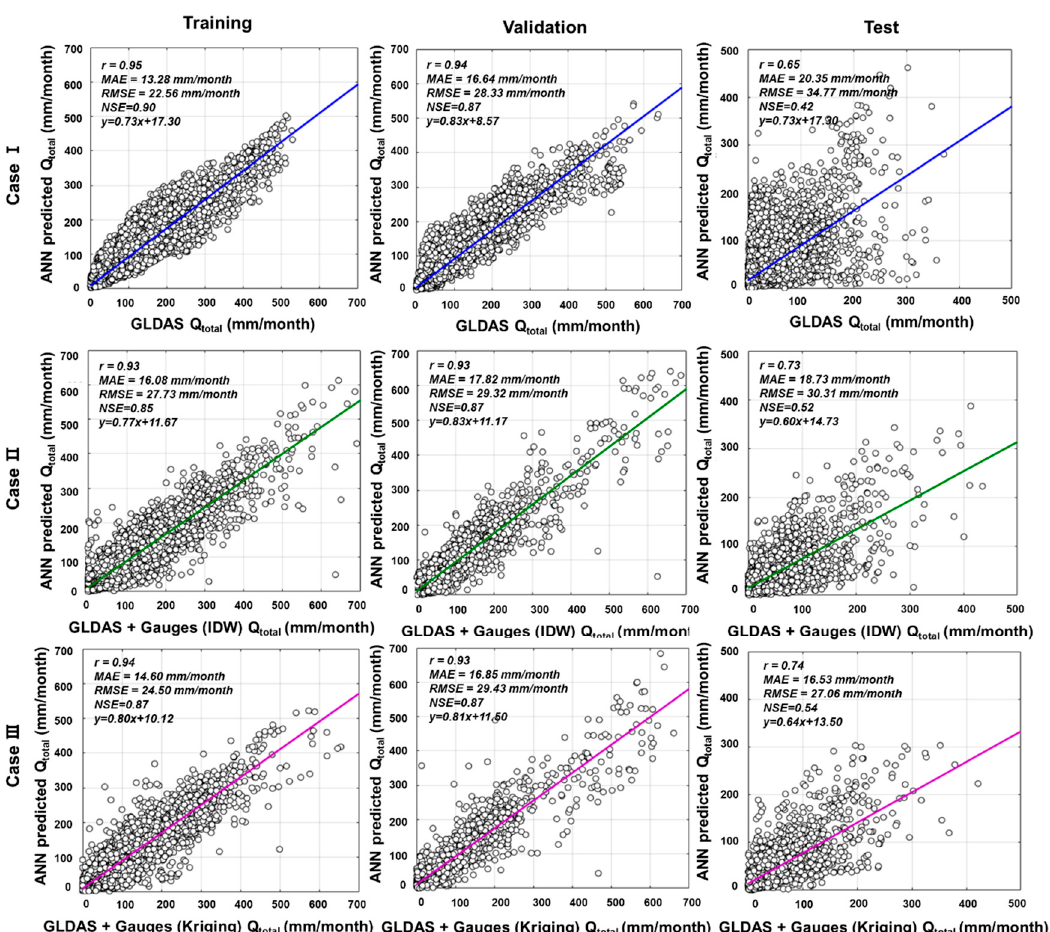
Figure 6. Modeling results for predicting the total discharge using ANN approaches at the 0.25° scale. r: correlation coefficient, MAE: maximum absolute error, RMSE: root mean square error, and NSE: Nash–Sutcliffe efficiency.